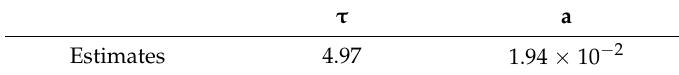
Figure 5. The distribution of the field data. Table 2. Estimated parameters in the Stochastic Partial Differential Equations.